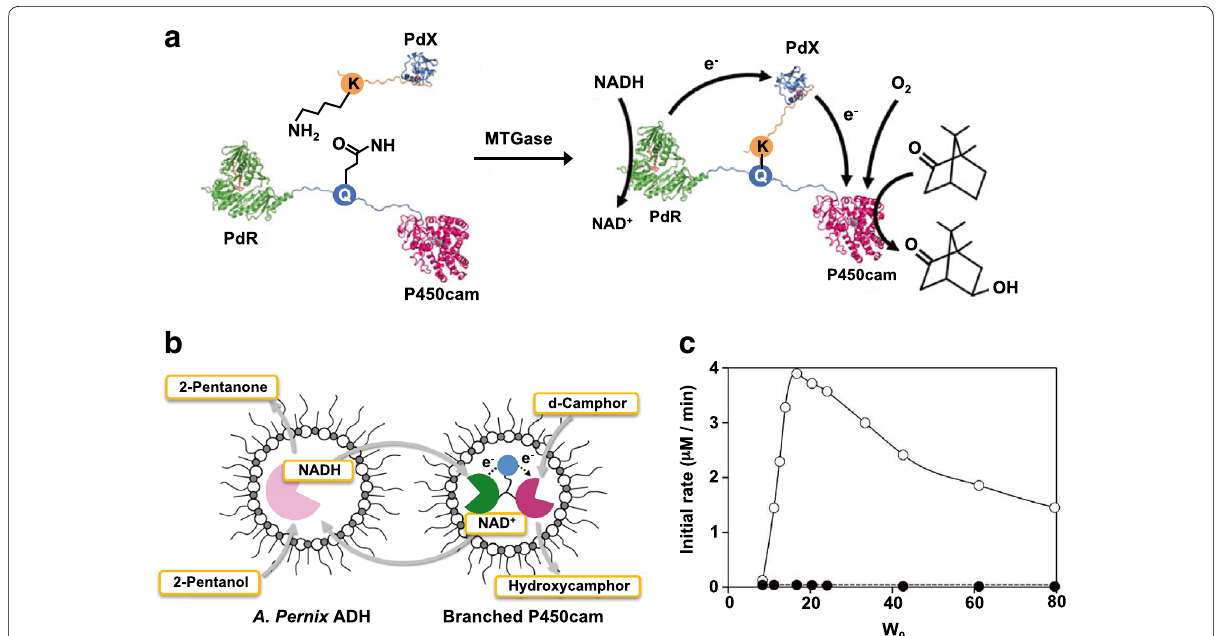
Fig. 11 The branched fusion protein construction by MTGase-mediated site-specific protein conjugation. a A fusion protein of putidaredoxin reductase (PdR) and P450cam linked with a peptide containing a reactive Gln residue and putidaredoxin attached K-tag generated a three-way branched fusion protein by MTGase. b Reaction scheme for d -camphor hydroxylation by branched P450cam with cofactor regeneration in a reversed micellar system. c Effect of W 0 on the initial activities of branched P450cam ( open circles ) and an equimolar mixture of PdR, PdX and P450cam ( closed circles ) ( a adapted with permission from: Ref. [106]. Copyright (2012) Springer, b , c adapted with permission from Ref. [109]. Copy- right (2010) Oxford University